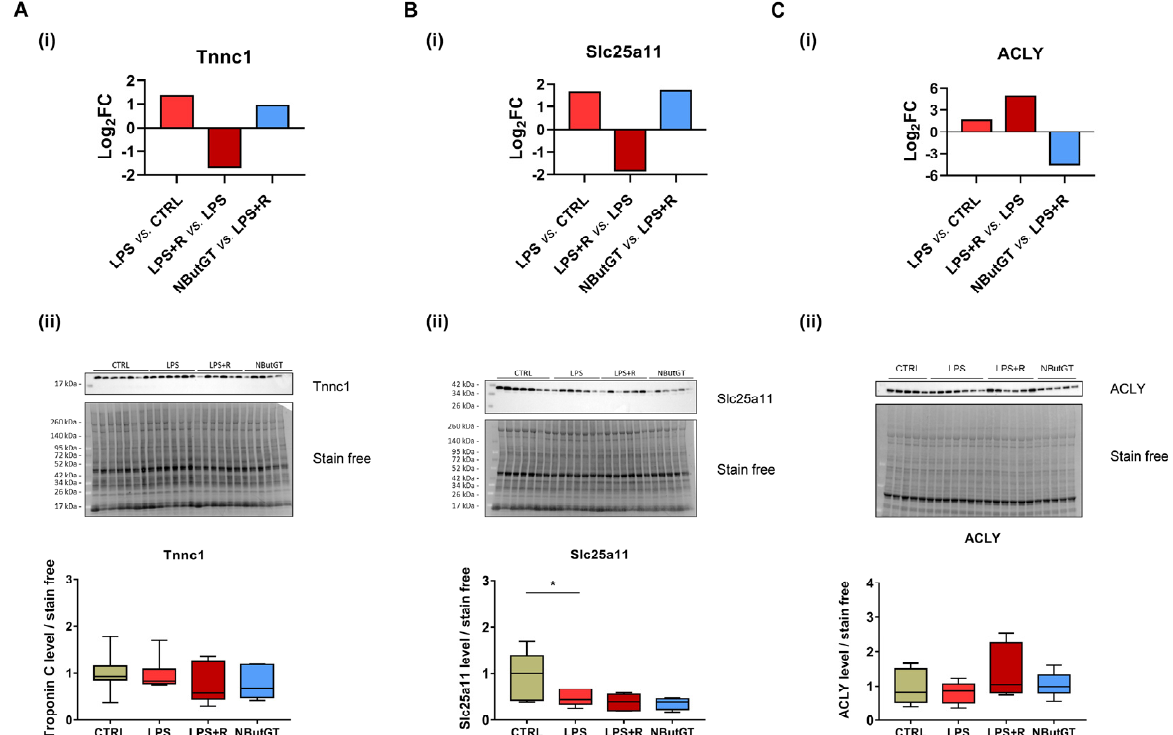
Figure 5. O -GlcNAcylation and expression of troponin C, mitochondrial 2-oxaloacetate/malate transporter protein and ATP-citrate lyase. Log 2 (fold change) of O -GlcNAcylation of troponin C ( A-i ), mitochondrial 2-oxaloacetate/malate transporter protein ( B-i ) and ATP-citrate lyase ( C-i ) between different groups. n = 2. Evaluation by Western blot of the expression of troponin C ( A-ii ), mitochondrial 2-oxaloacetate/malate transporter protein ( B-ii ) and ATP-citrate lyase ( C-ii ) in different groups. Statistical significance was assessed by Kruskal–Wallis test with uncorrected Dunn’s post-test (*: p < 0.05). Quantification was in relation to stain free. Results are expressed as mean ± SEM. CTRL: control group, LPS: i.v. injection of LPS (20 mg/kg), LPS+R: subcutaneous administration of 10 mL/kg of NaCl 0.9%, NButGT: resuscitation supplemented with NButGT (10 mg/kg). n = 6–7.